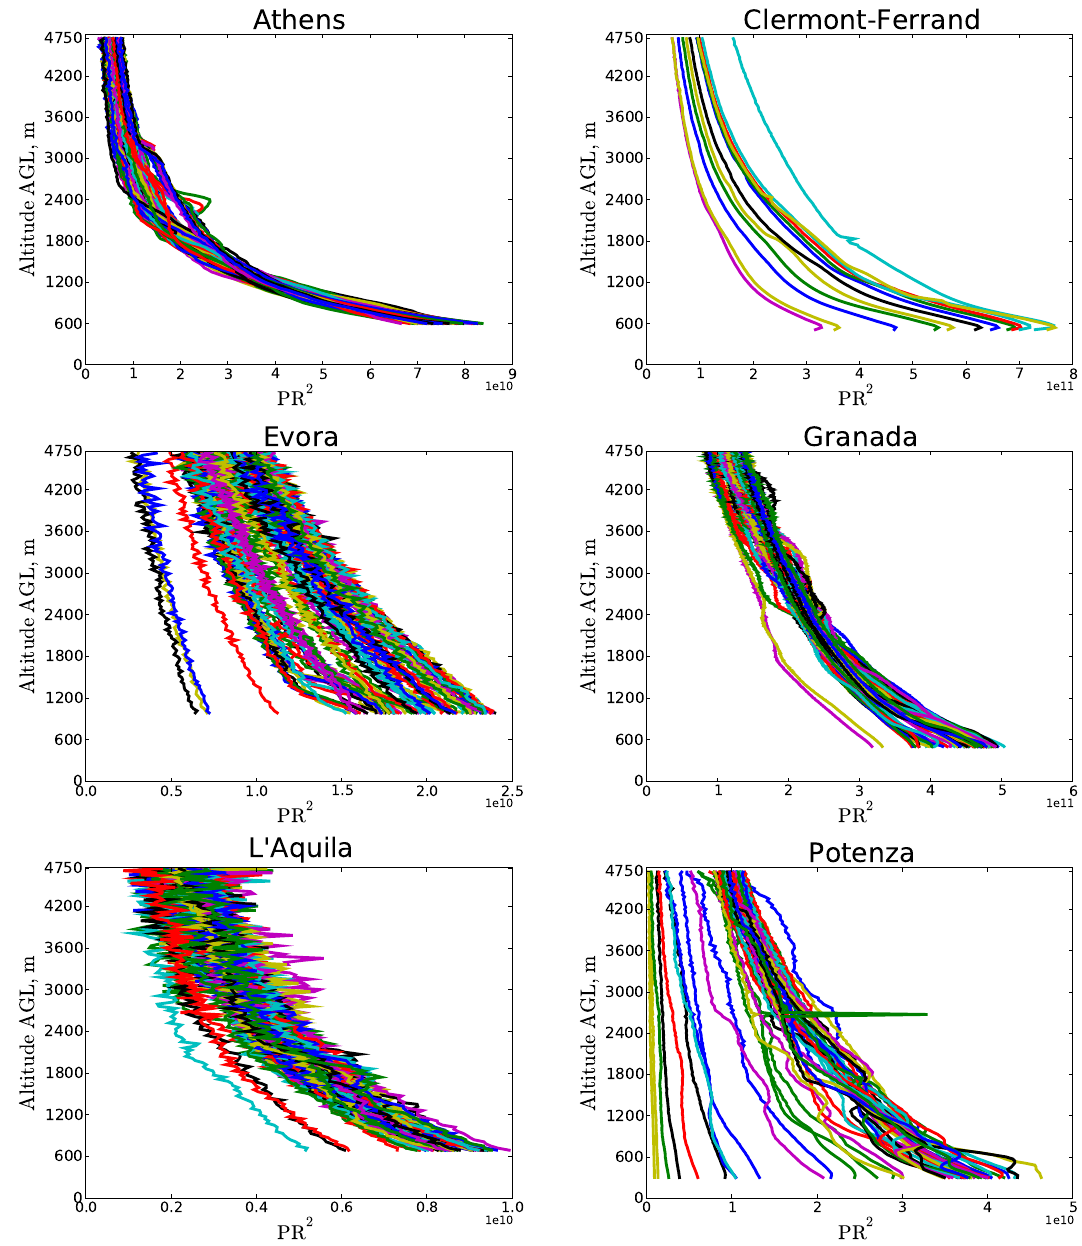
Figure 2. Hourly averaged range-corrected lidar signals (PR 2 ) from 06:00UTC 9 July to 06:00UTC 12 July at the Athens, Clermont-Ferrand, Evora, Granada, L’Aquila and Potenza lidar Figure 2. Hourly-averaged range corrected lidar signals (PR 12 July at Athens, Clermont-Ferrand, Evora, Granada, L’Aquila and Potenza lidar stations.